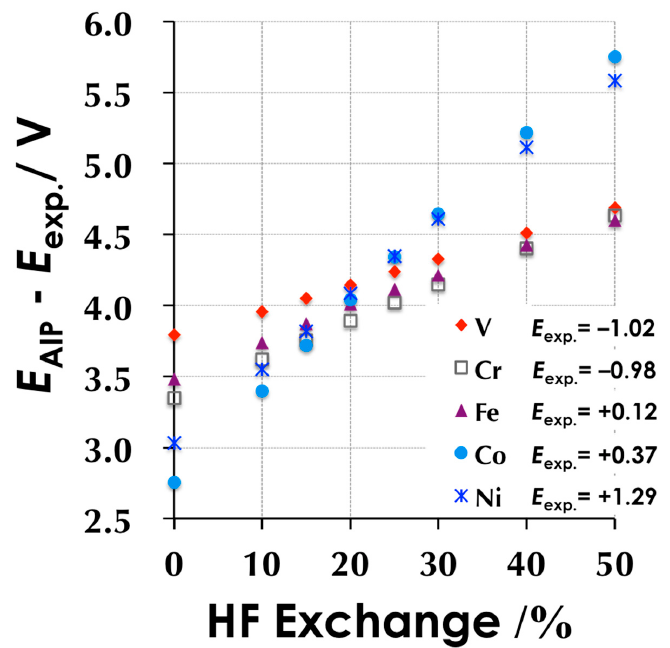
Figure 1. The dependency of E AIP − E exp on the HF ratio for the M II/IIII (EDTA) complexes. (M = V, Cr, Fe, Co, and Ni.) The experimental redox potential (in V) is listed in the figure.